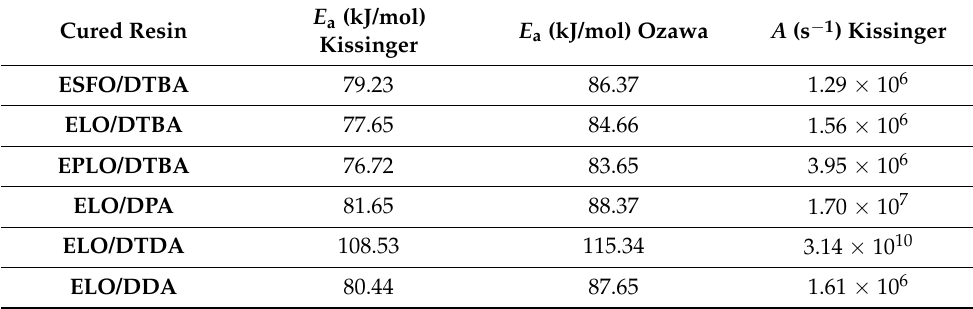
Table 2. Kinetic parameters determined by fitting non-isothermal DSC